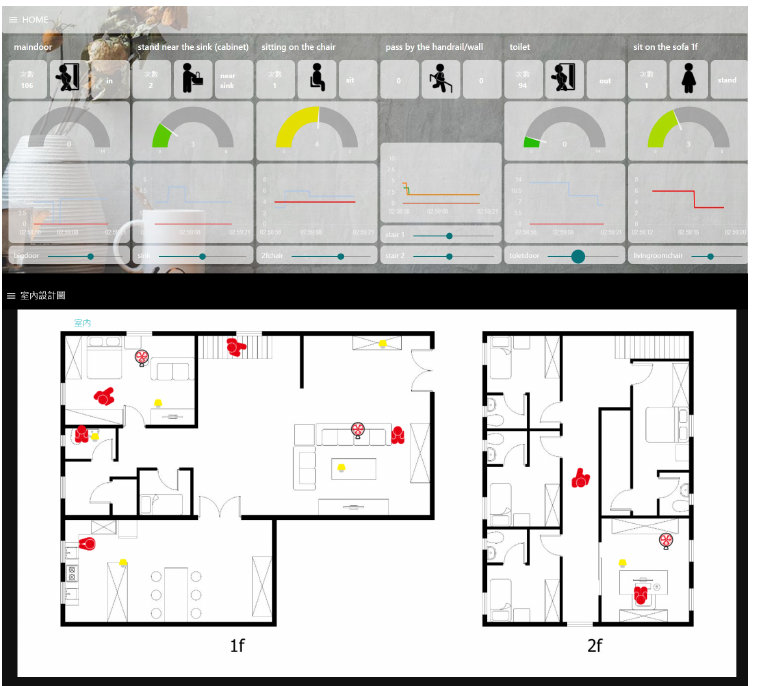
Figure 8. Dashboard application of the visualization sensor data and the movement trajectory of the ‘Move–Stop’